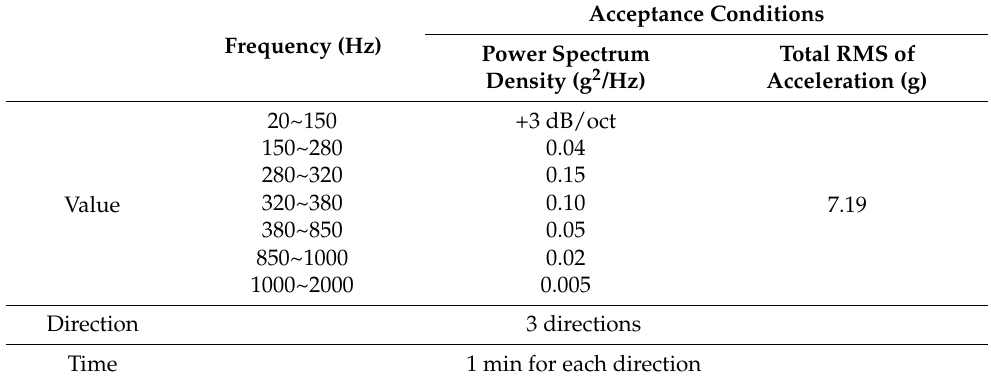
Table 6. Random vibration test conditions.